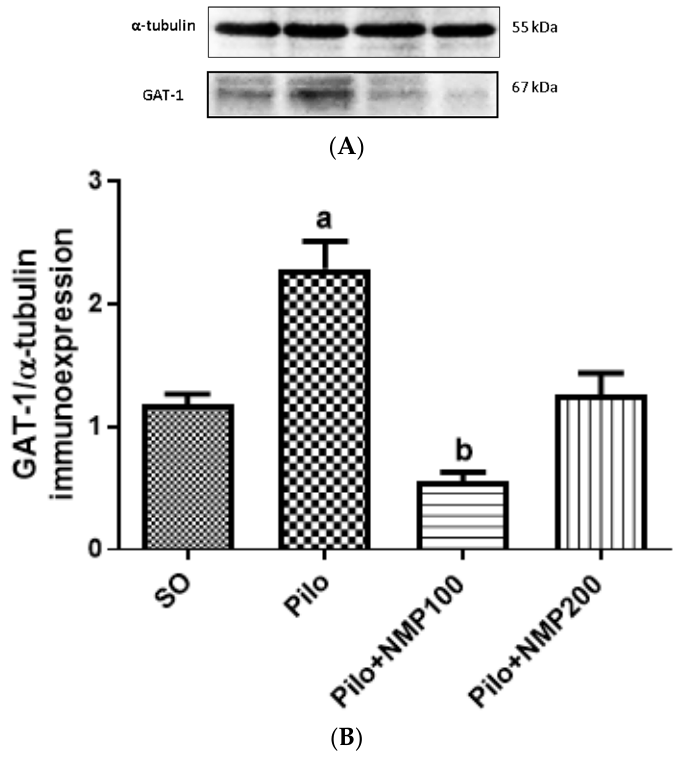
Figure 8. The N -methyl-(2S,4R)-trans-4-hydroxy- L -proline-rich fraction (NMP) partly prevented the increased γ -aminobutyric acid (GABA) transporter (GAT-1) expression in mice subjected to the intracerebroventricular (icv) injection of pilocarpine (Pilo), compared with the SO group as evaluated by western blot analysis. Representative blots ( A ) show the higher intensity band, which corresponds to standard α -tubulin (55 kDa), and the 67 kDa band corresponding to the GAT-1 band (four mice per group). Below, the densitometric quantification of the bands is shown ( B ), as performed by the ImageJ software (National Institute of Health - NHI, USA). a. vs. SO, p < 0.0014; b. vs. SO, p < 0.0293 (Kruskal–Wallis test and Dunn’s multiple comparisons test).